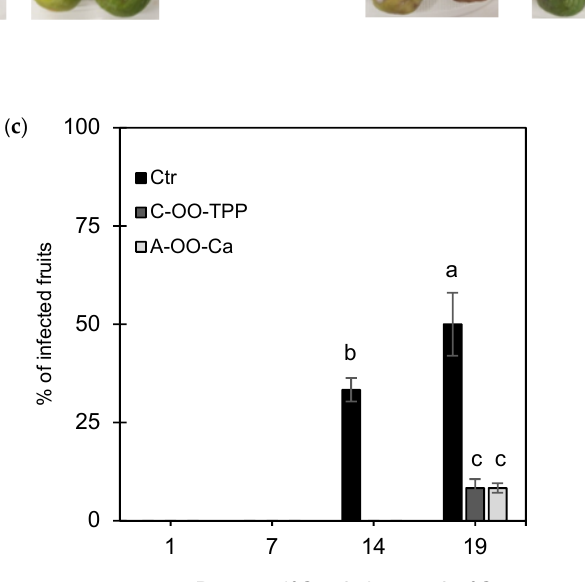
Figure 2. Figs ( Ficus carica L. var. ´ Pingo de mel ´ ) with crosslinked chitosan-olive oil and alginate-olive oil emulsion-based coatings (C-OO-TPP and A-OO-Ca, respectively) and uncoated control (Ctr), during storage at 4 °C ( a ), and after being transferred to room temperature for 2 days ( b ); fungal disease incidence ( c ). Means followed by equal letters, after storage, do not differ by Tukey’s test at 5% of error probability. RH: Relative humidity.